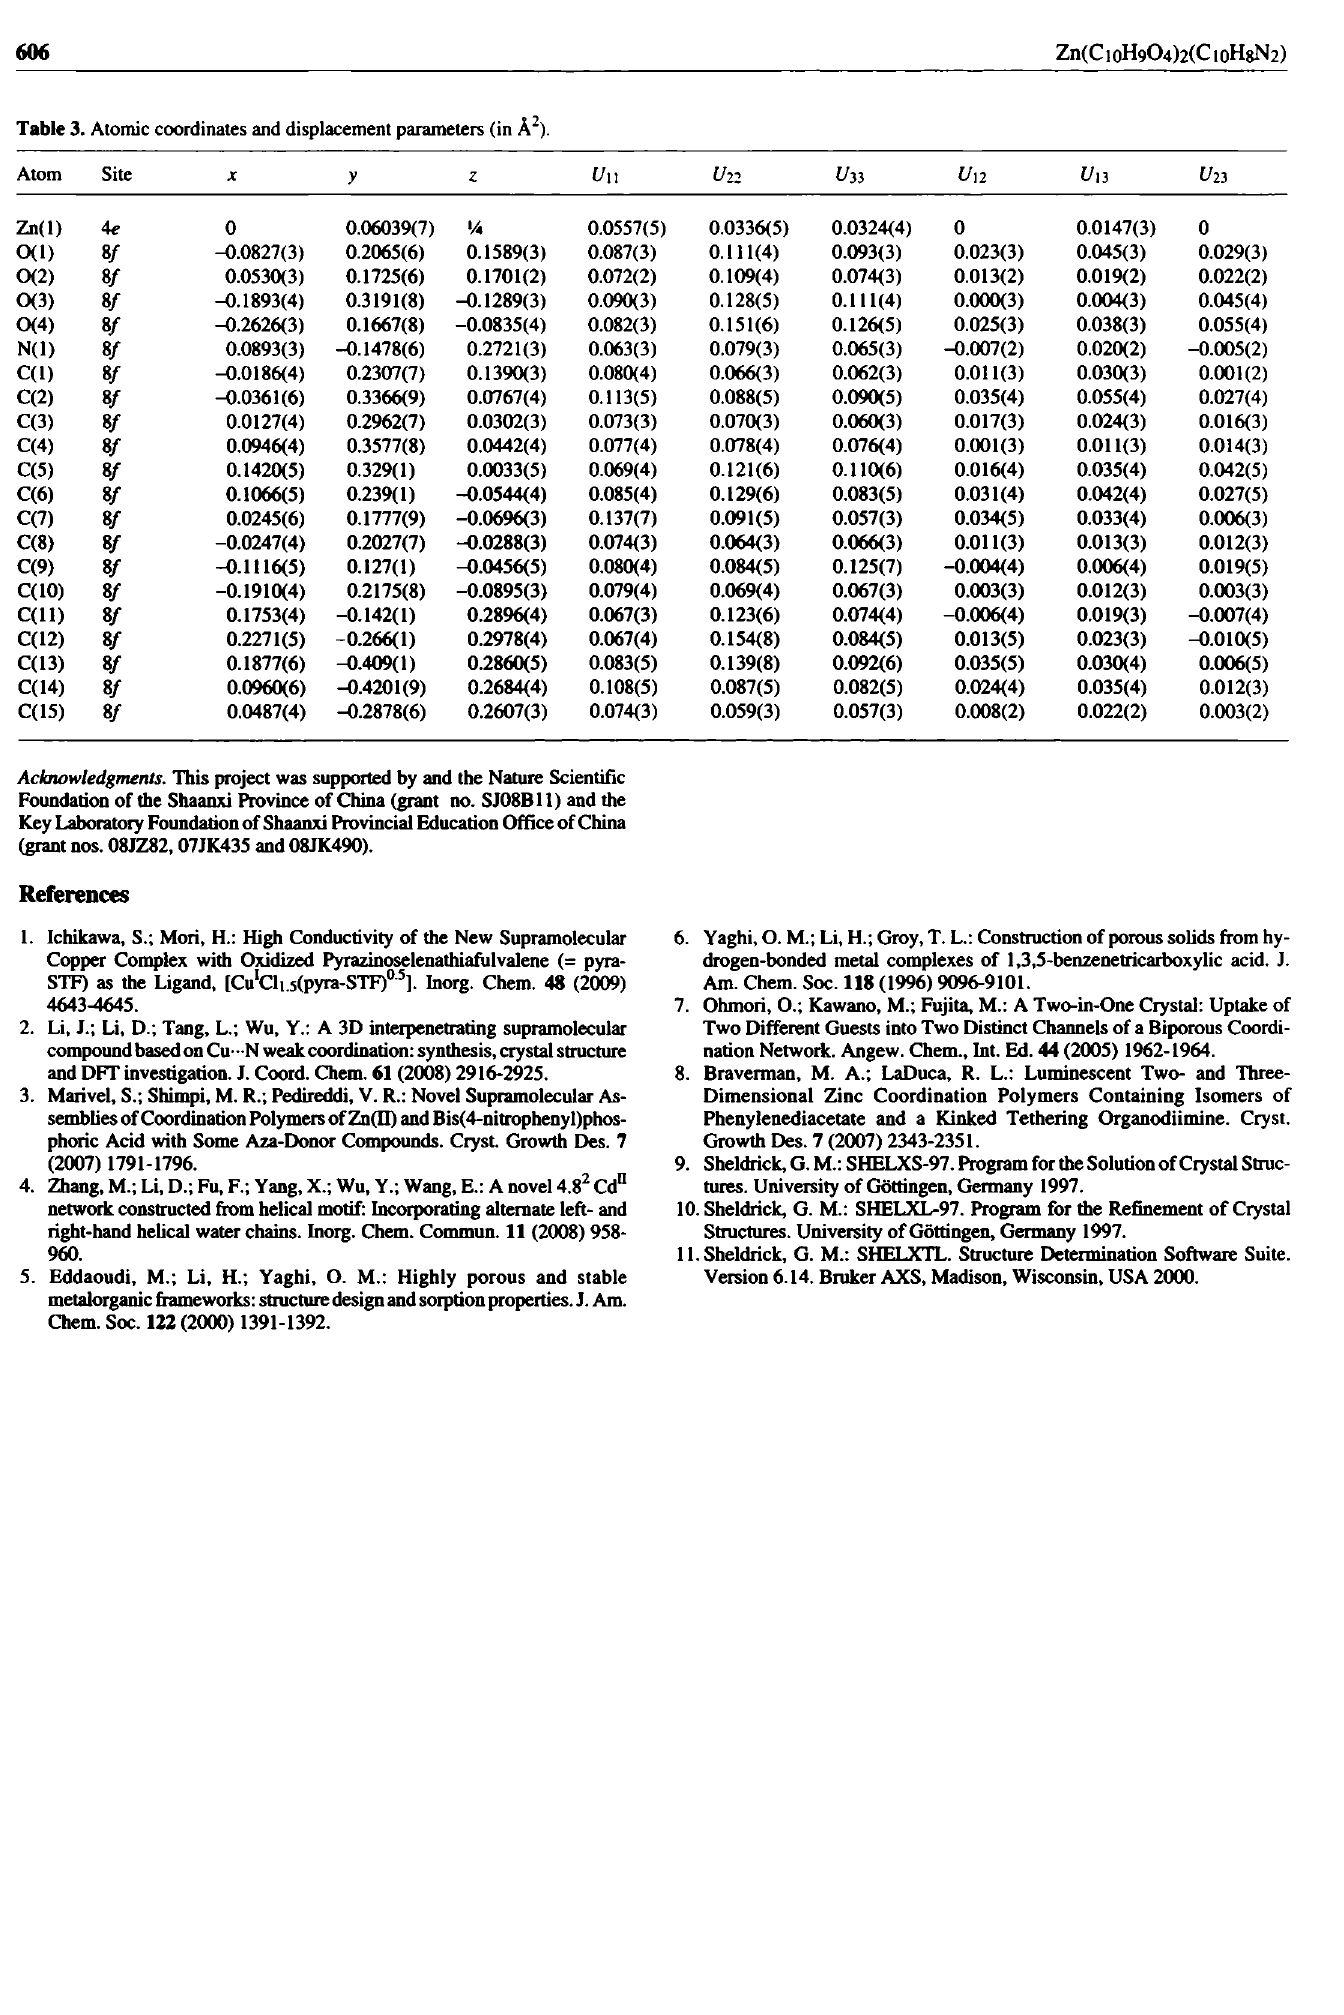
Table 3. Atomic coordinates and displacement parameters (in Â 2